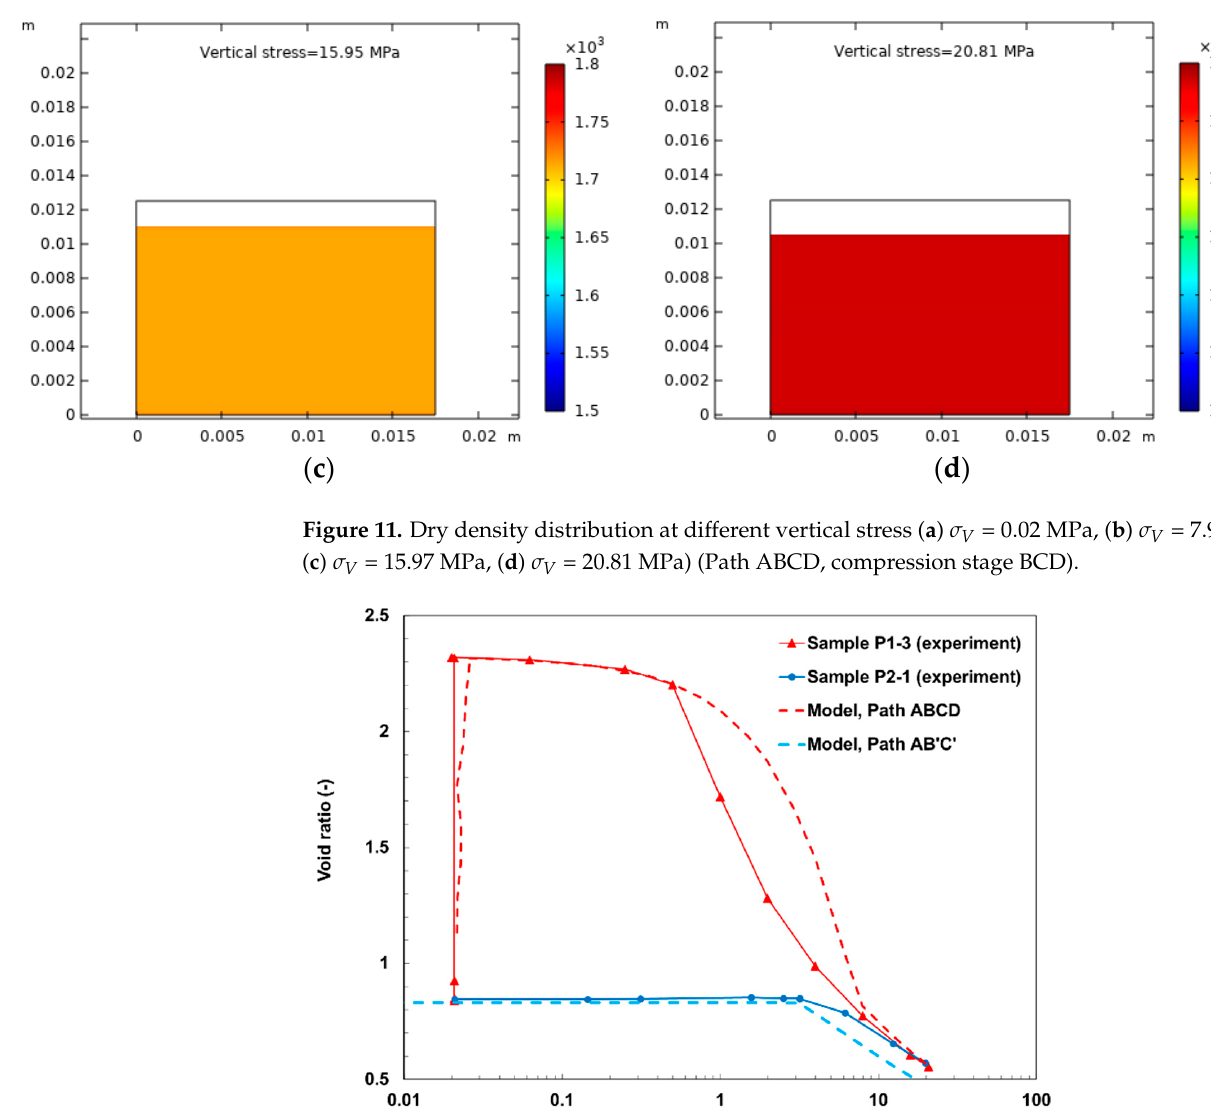
Figure 11. Dry density distribution at different vertical stress ( a ) 𝜎 (cid:3023) = 0.02 MPa, ( b ) 𝜎 (cid:3023) = 7.97 MPa, ( c ) 𝜎 (cid:3023) = 15.97 MPa, ( d ) 𝜎 (cid:3023) = 20.81 MPa) (Path ABCD, compression stage BCD).